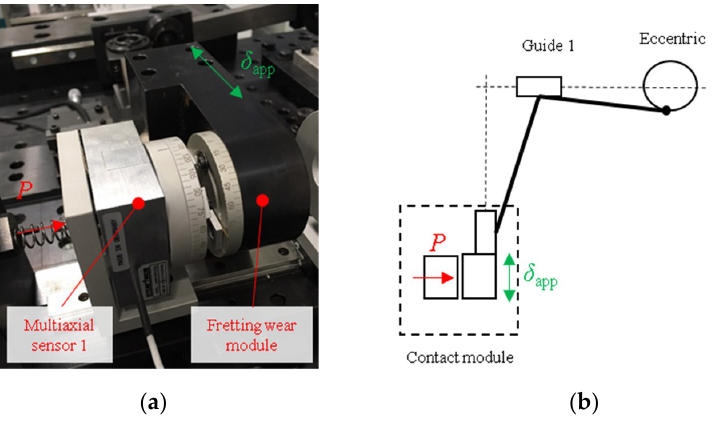
Figure 6. ( a , b ) The contact module for fretting wear configuration.